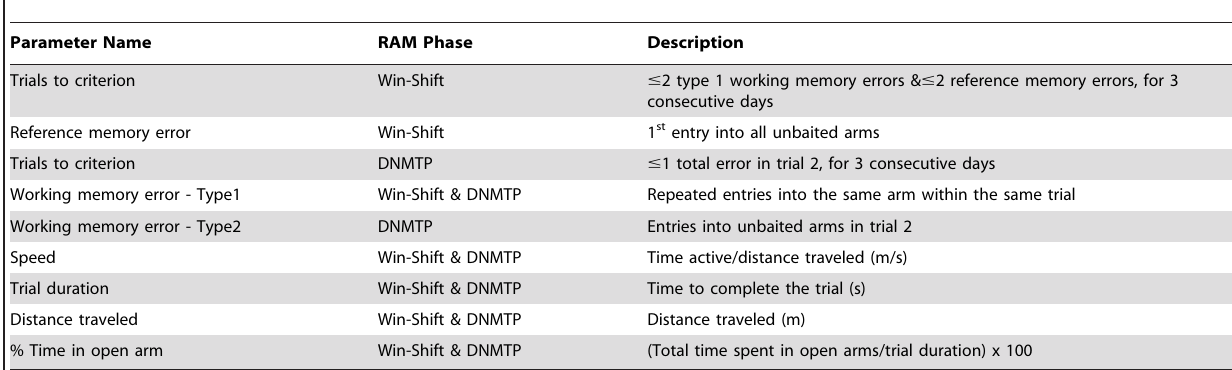
Table 1. Description of trials to criterion and the dependent measures used in the RAM